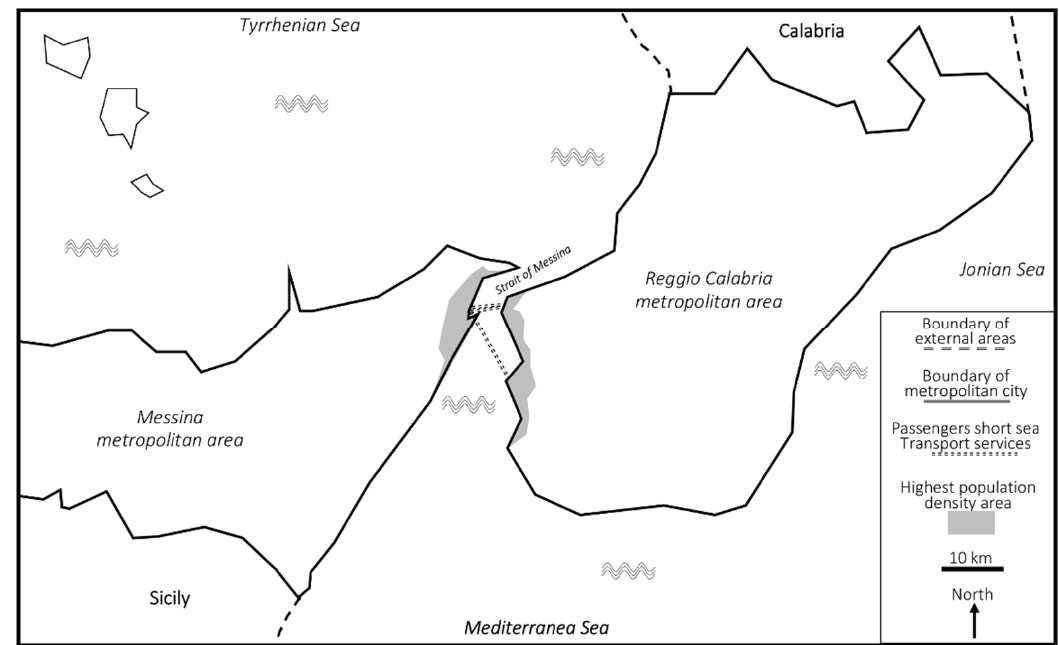
Figure 6. Strait of Messina: study area.